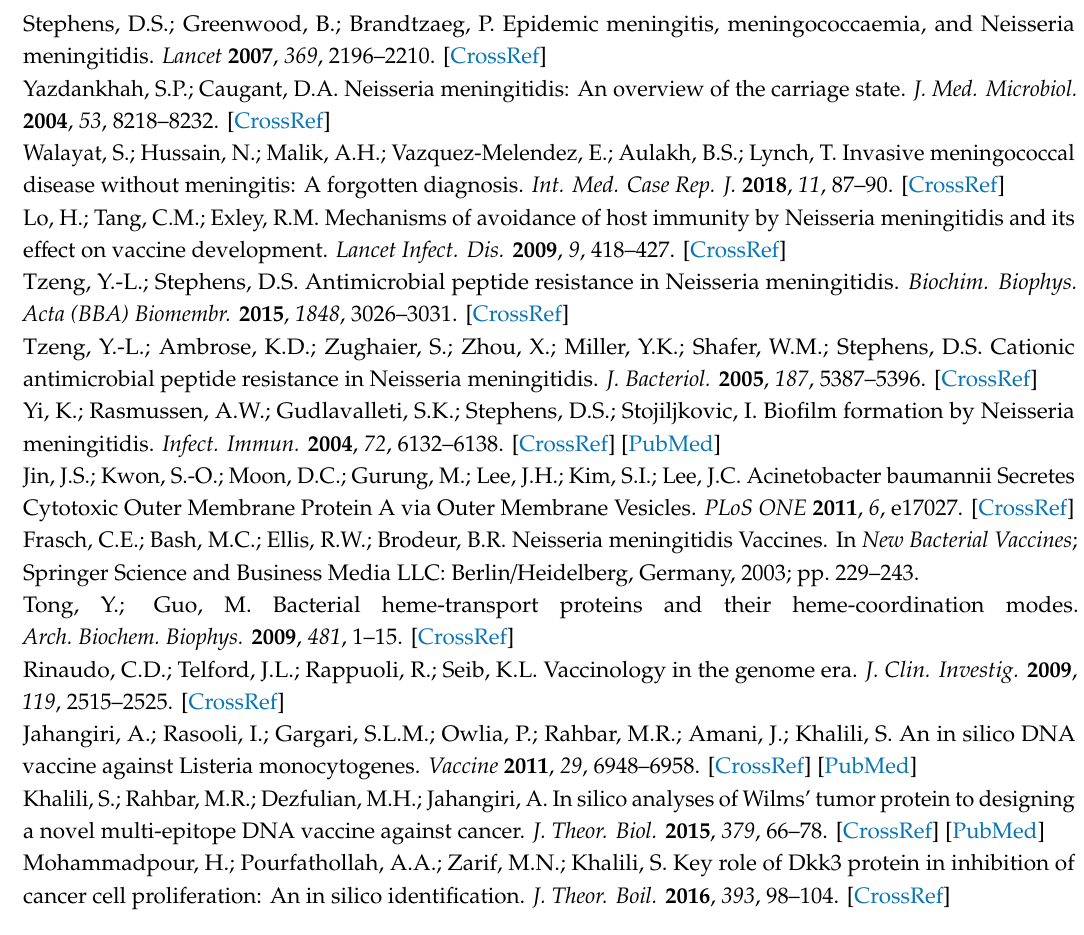
Table S1: Antigenic and immunogenic properties of